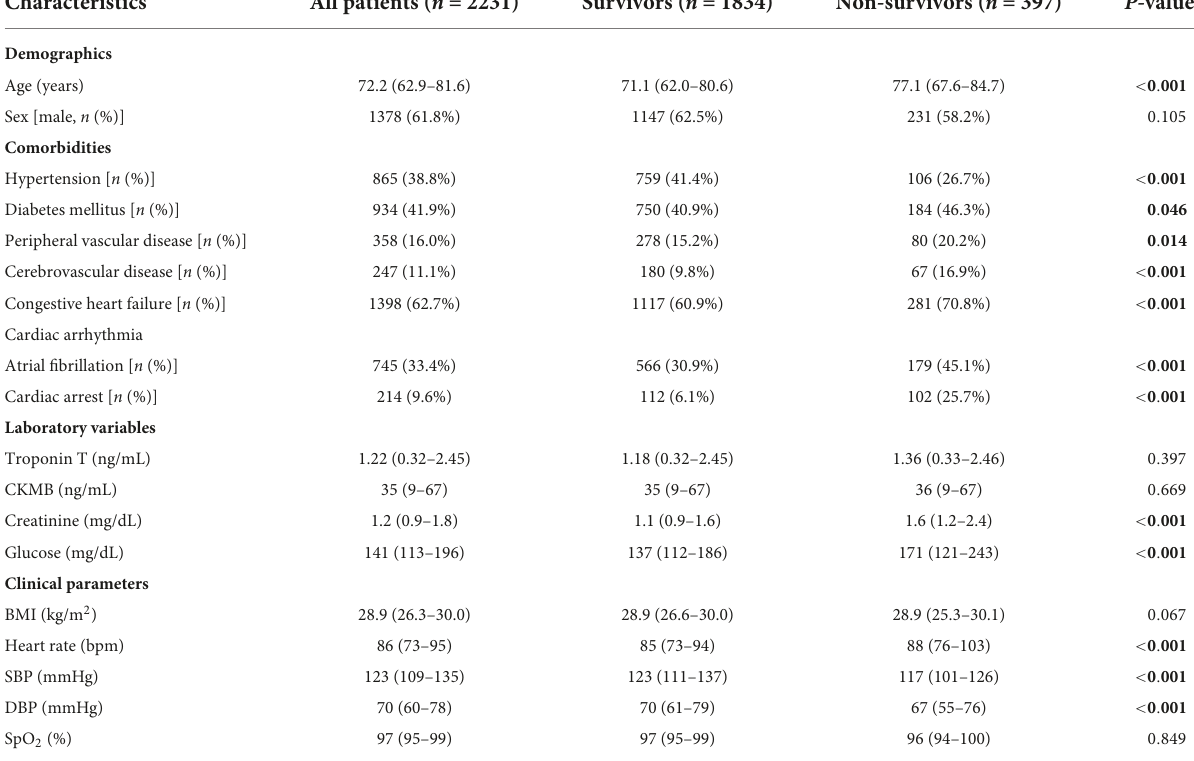
TABLE 2 Comparison of baseline clinical characteristics between survivors and non-survivors in the included cohort.